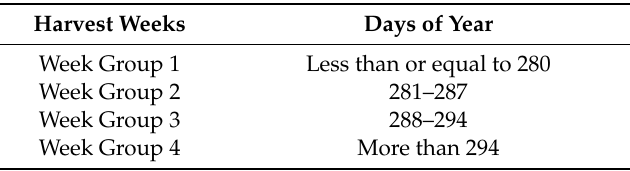
Table 1. Week group division.